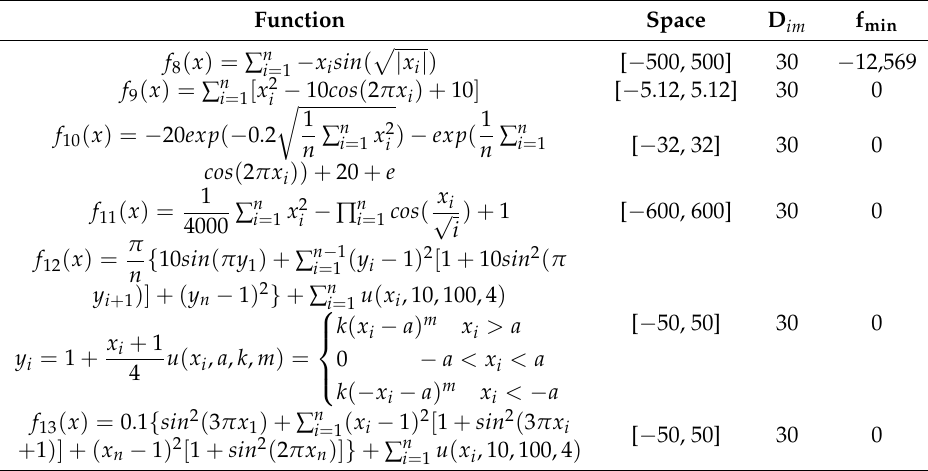
Table 2. Multimodal benchmark functions.